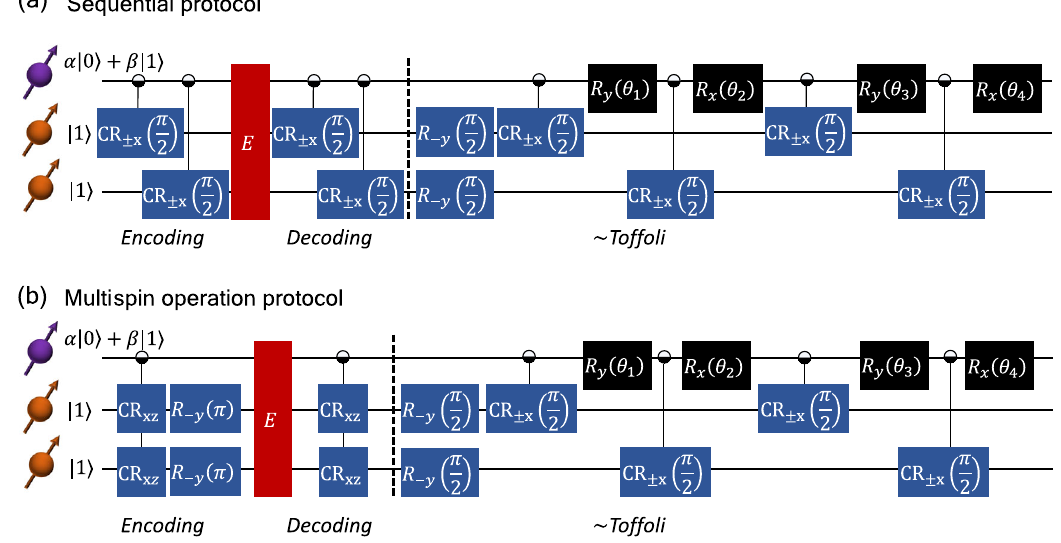
π = 2 Þ gates and (b) the FIG. 18. Circuit diagrams to correct a bit flip on the electron for (a) the sequential approach that utilizes the CR x ð multispin operation protocol. E denotes the bit-flip error, which can happen either on the electron or on one of the nuclei. In (b), we π Þ unconditional rotations on the nuclear spins for the encoding step. These rotations can be performed at either further require the R − y ð the encoding step after the CR gate or the decoding step before the CR gate. The half-white, half-black circles of the control of the xz xz CR ð π = 2 Þ gates indicate that, depending on the electron ’ s state, the nuclear spin rotates by R x ð π = 2 Þ or R x ð − π = 2 Þ . For the CR xz gates, (cid:4) x the half-white, half-black notation means that, depending on the electron ’ s state, the nuclear spin rotates by R n or R n 0 1